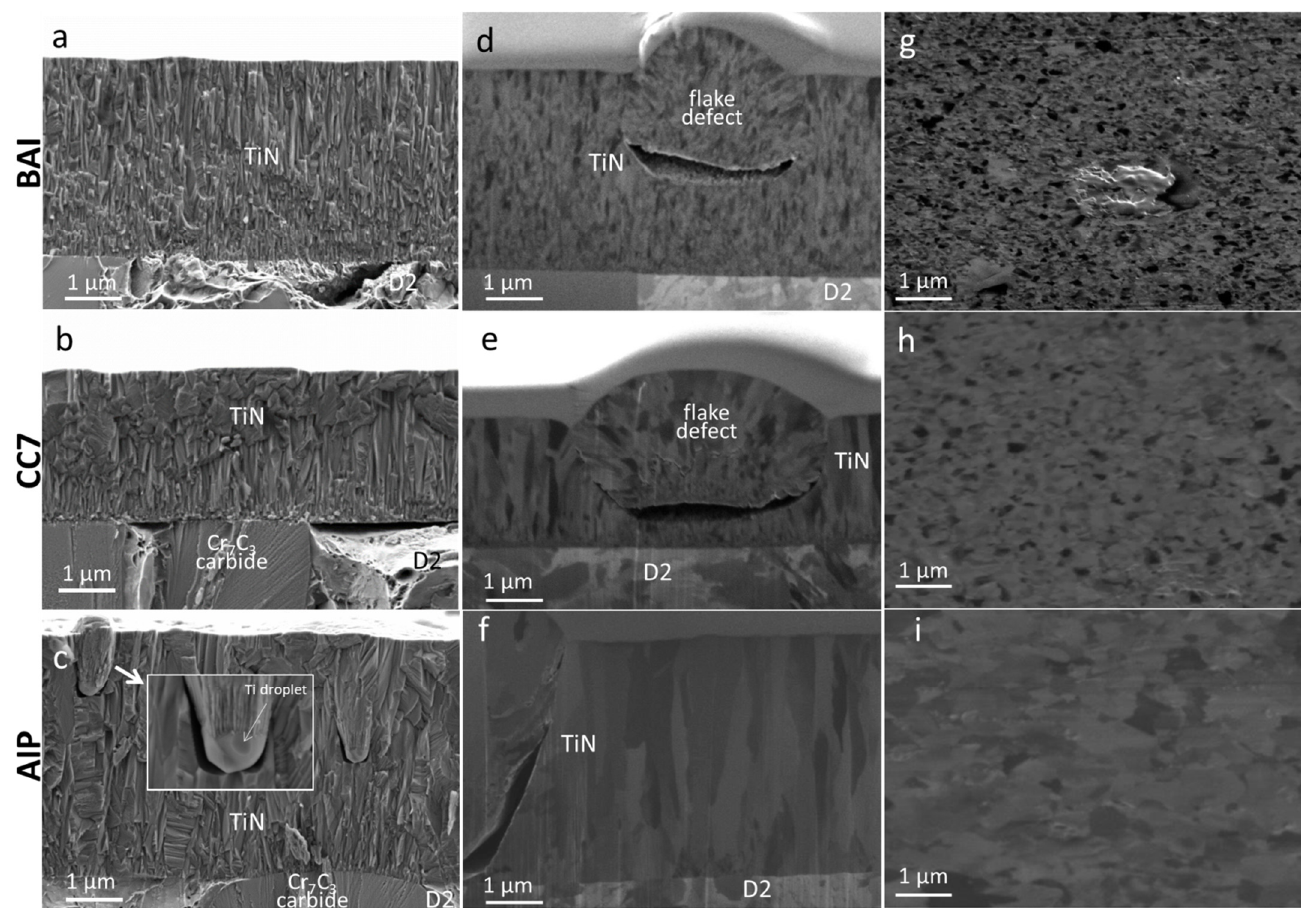
Figure 1. Fracture cross-sectional SEM images ( a – c ), FIB secondary electron images of cross-sections ( d – f ), and FIB secondary electron top view images ( g – i ) of TiN coatings deposited by low-voltage electron beam evaporation, magnetron sputtering and cathodic arc deposition techniques.